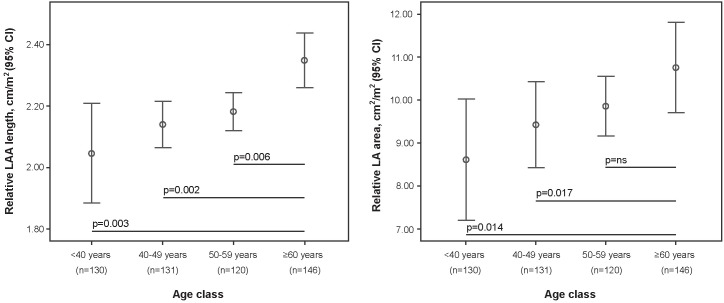
Relative Left Atrial Appendage (LAA) length and relative Left Atrium (LA) area according to age quartile, with 95% confidence intervals.